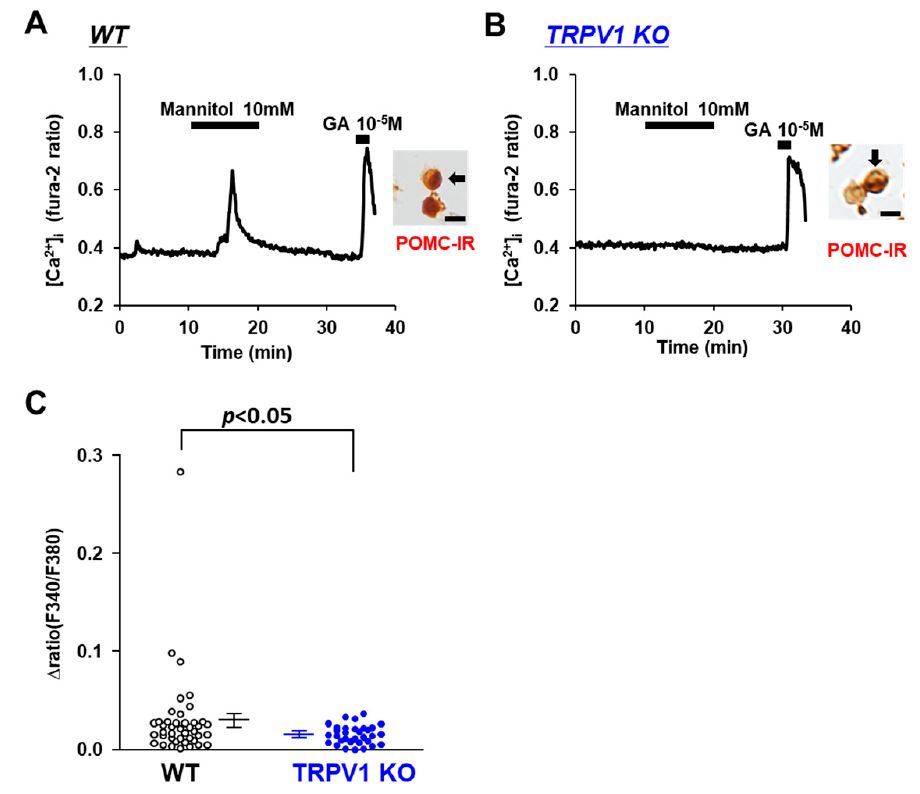
Figure 4. Mannitol increased [Ca 2+ ] i in single POMC neurons in ARC. ( A , B ) Typical example of [Ca 2+ ] i responses to mannitol and 10 − 5 M glutamate (GA) in POMC neurons isolated from wild-type (WT) mice ( A ) and Trpv1 KO mice ( B ). Scale bar is 20 μ m. ( C ) Average amplitude of [Ca 2+ ] i responses to mannitol ( Δ ratio) in POMC neurons. Data are presented as mean ± SEM. WT vs. KO determined by one-way ANOVA followed by the Bonferroni test.